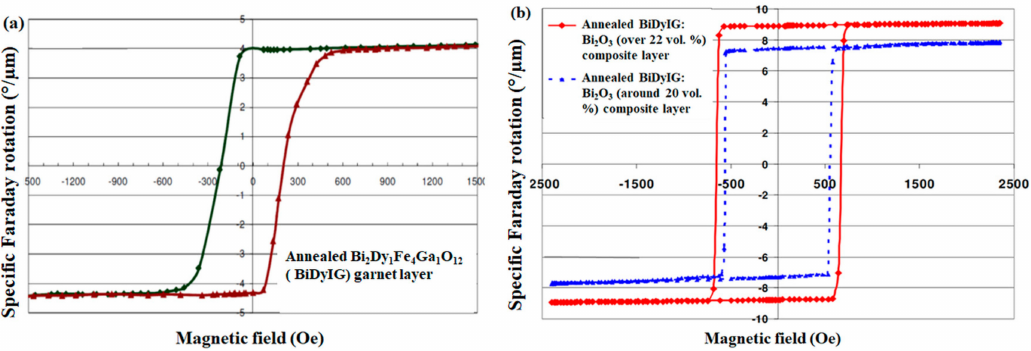
Figure 3. Hysteresis loops of specific Faraday rotation at 532 nm measured in sputtered garnet films. ( a ) Annealed (nanocrystalline) Bi 2 Dy 1 Fe 4 Ga 1 O 12 (BiDyIG) sample, and ( b ) annealed BiDyIG: Bi 2 O 3 composite-type oxide-diluted thin films